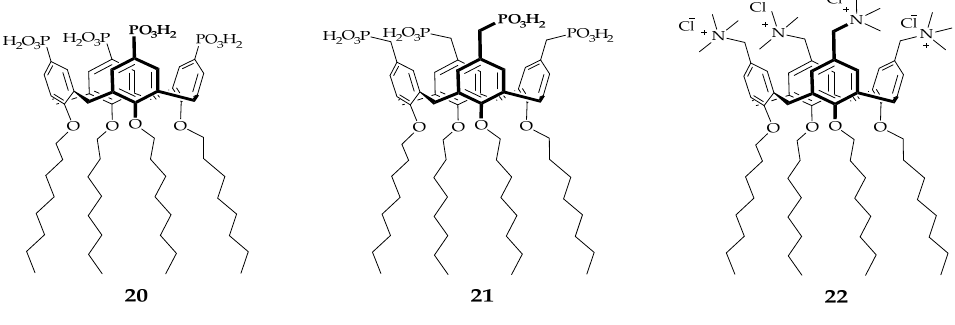
Figure 4. Structures of calix[4]arene derivatives 20 – 22 .